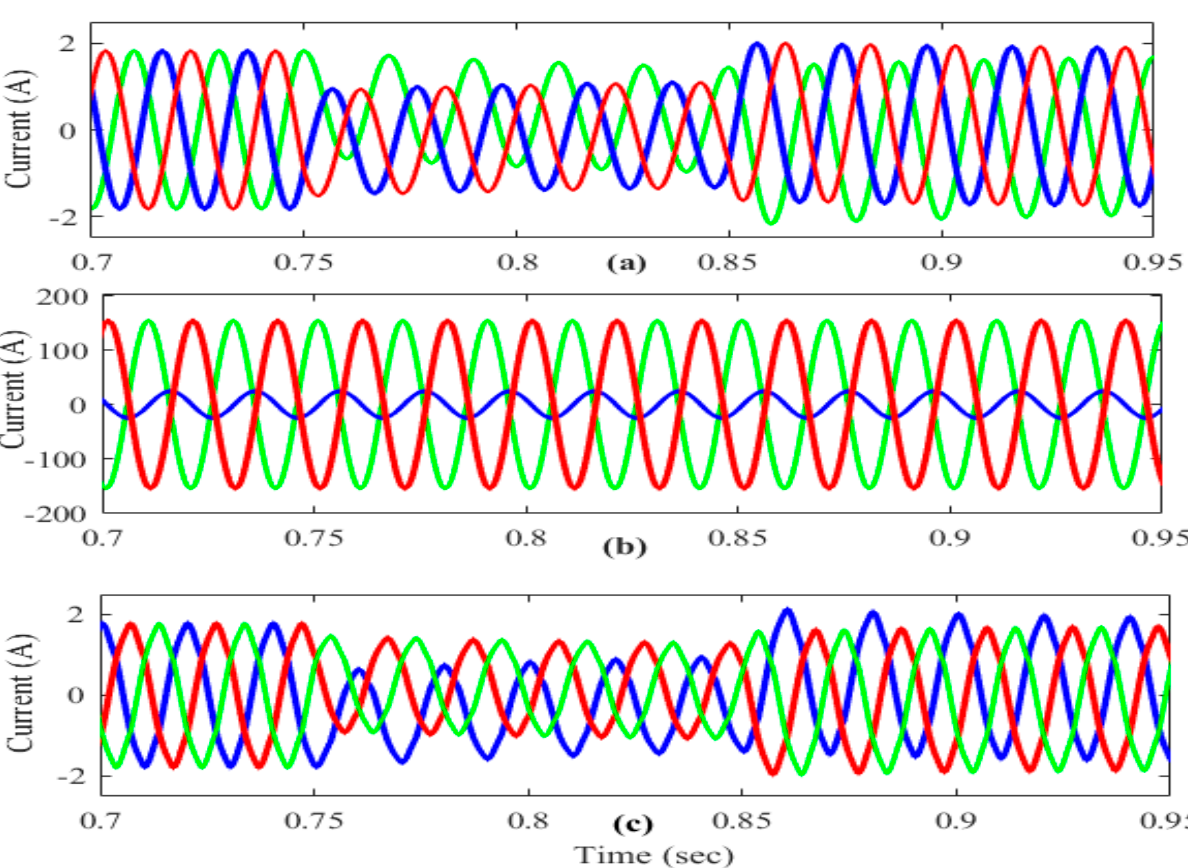
Figure 15. Current Sag Condition ( a ) Source current ( b ) Load current ( c ) Injected current.